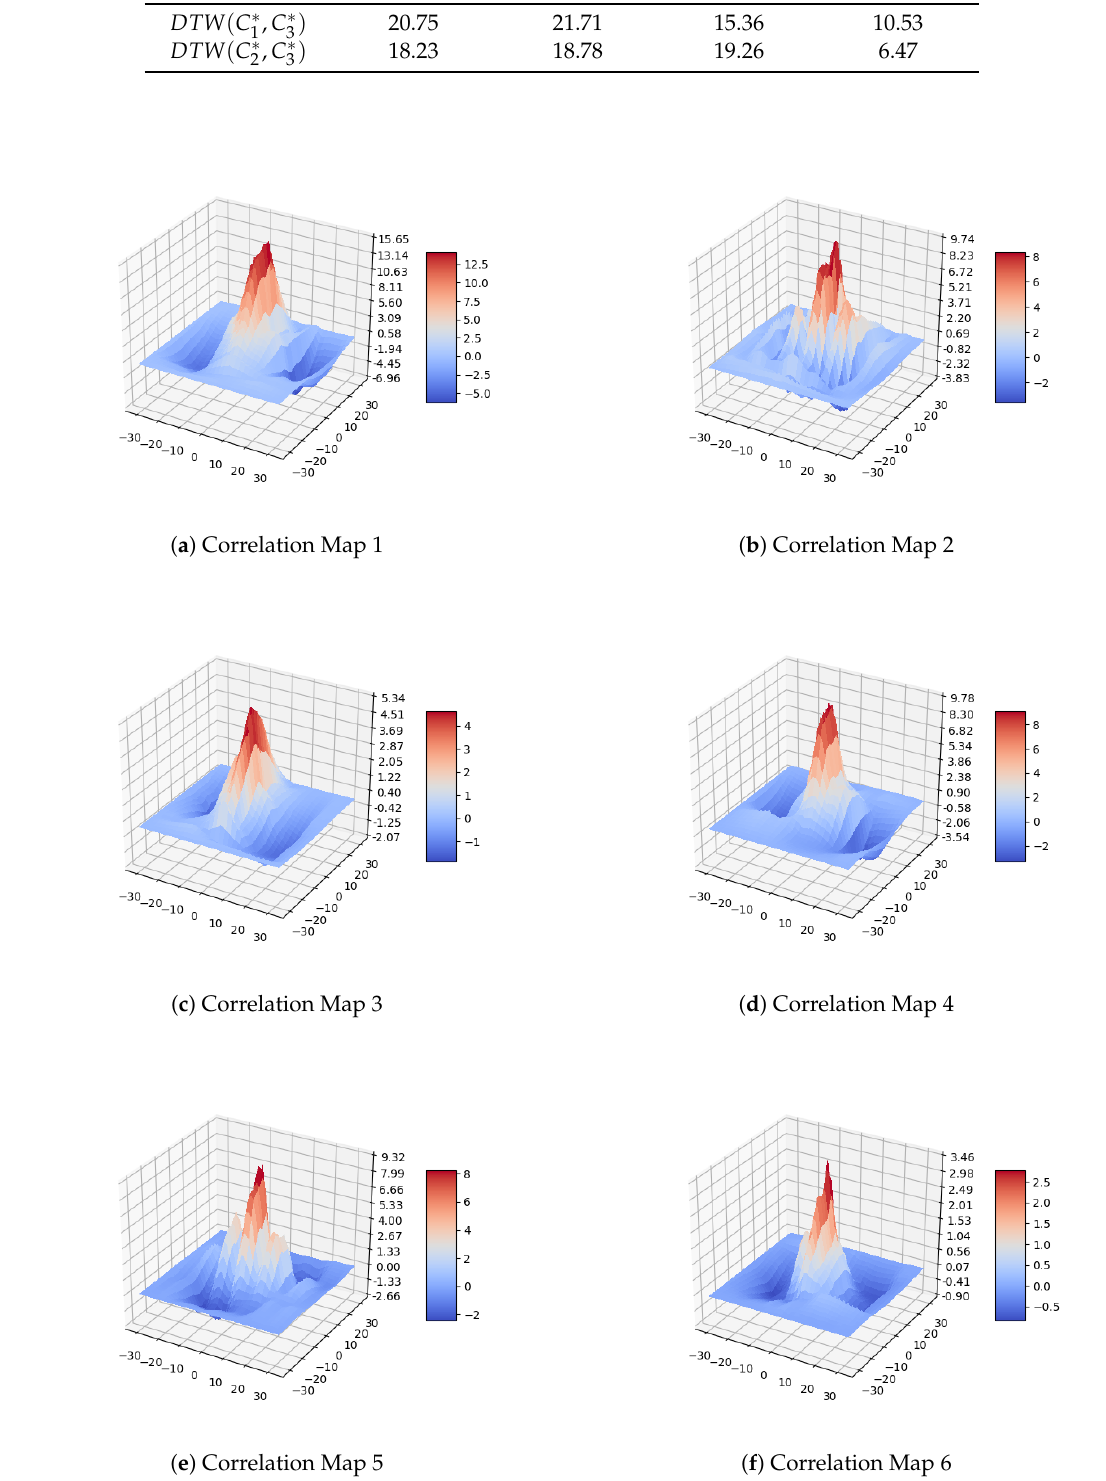
Figure A2. 3D plots of correlation matrices of the vectors in Figure A1c. Each row in the figure corresponds to each row in the vector plot of Figure